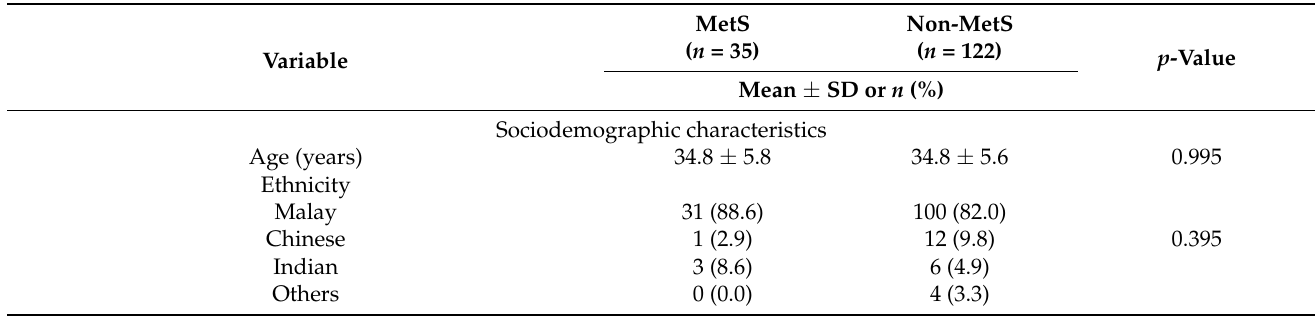
Table 2. Comparison of sociodemographic and obstetric characteristics between participants with and without metabolic syndrome ( n =